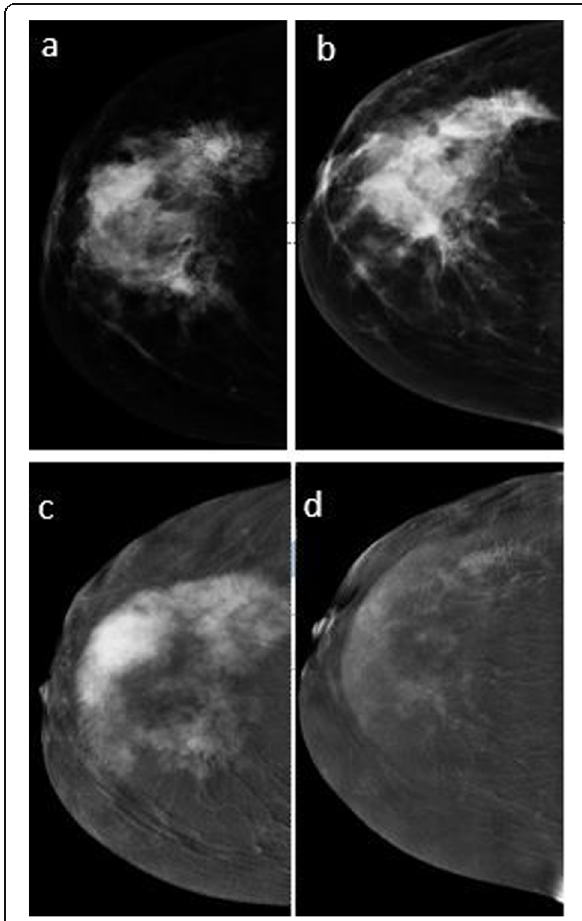
Fig. 7 a Pre-NAC mammogram; sSpiculated UOQ and UIQ masses. b Post-NAC mammogram; mild reduction mild reduction in size. c Pre- NAC CESM; grouped lesions. d Post-NAC CESM; type III shrinkage. RECIST 1.1; non-responder. Combined response evaluation; partial